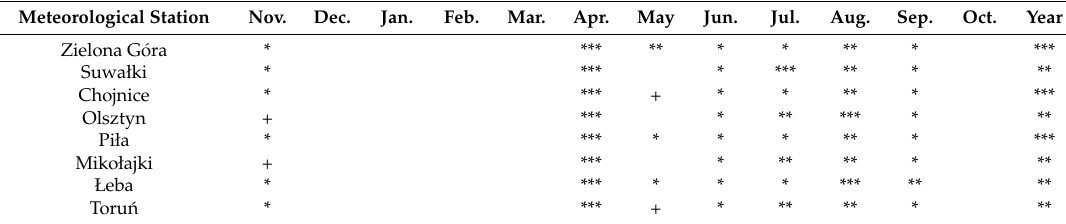
Table 3. Significance of trends of air temperature.